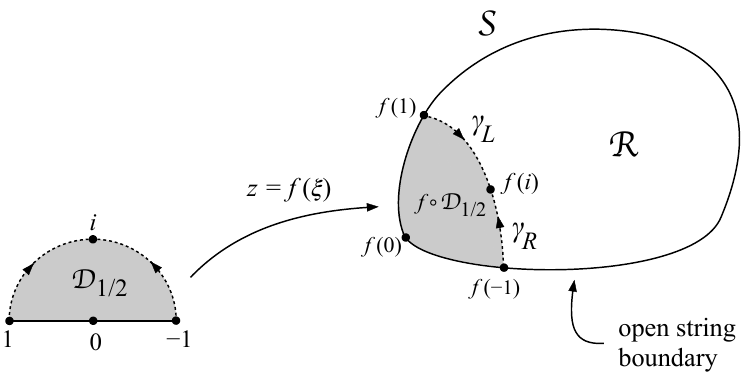
Figure 6 . Illustration of the data specifying a generic surface state j S i